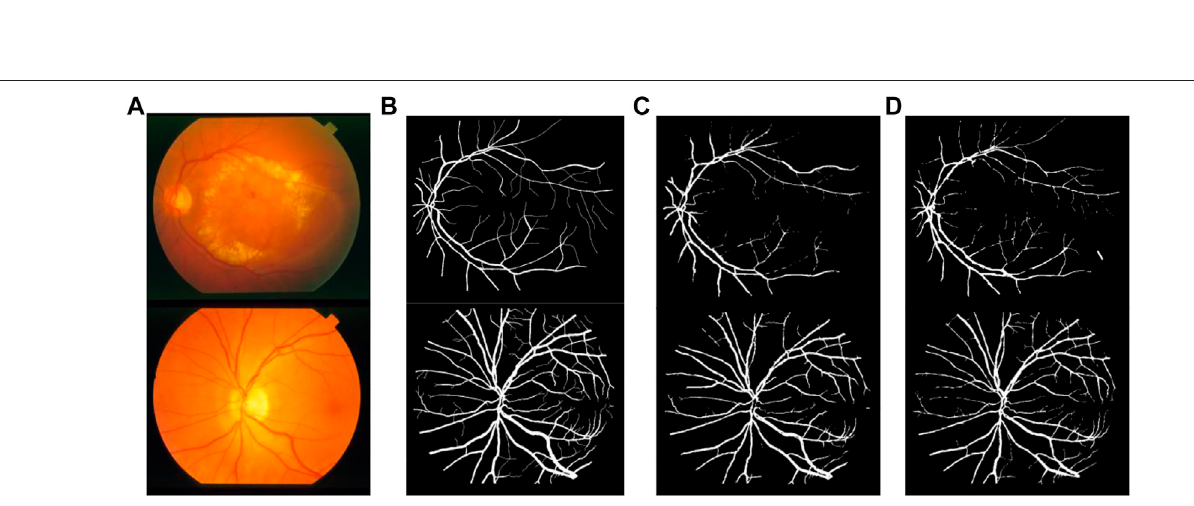
FIGURE13| ComparisonofsegmentationresultsofdifferentalgorithmsonSTAREdatasets: (A) Originalfundusimage, (B) Referencestandard, (C) ResultsinRef. (Fan et al., 2019), and (D) Results by proposed method.